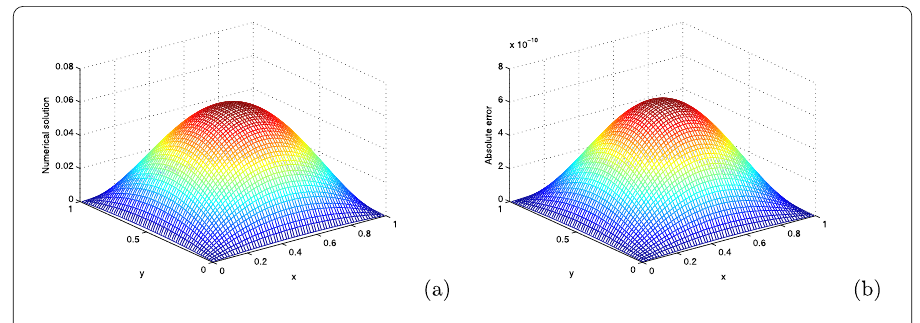
Figure 4 Numerical solution ( a ) and global error ( b ) for Example 3 with α = 0.9 at T = 1 ( h = 1/32, τ = 1/32)